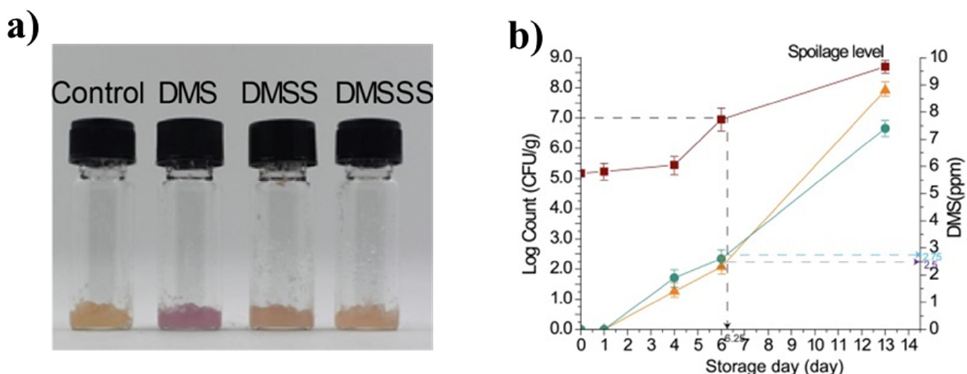
Figure 9. ( a ) Naked-eye sensing response of solid-supported chemosensor toward DMS; ( b ) changes in microbial counts (brown line) and DMS concentration measured by UV-Vis (green line) and GC-MS (orange line) for beef samples stored at 4 ◦ C. Reprinted with permission from ref. [158]. Copyright 2019